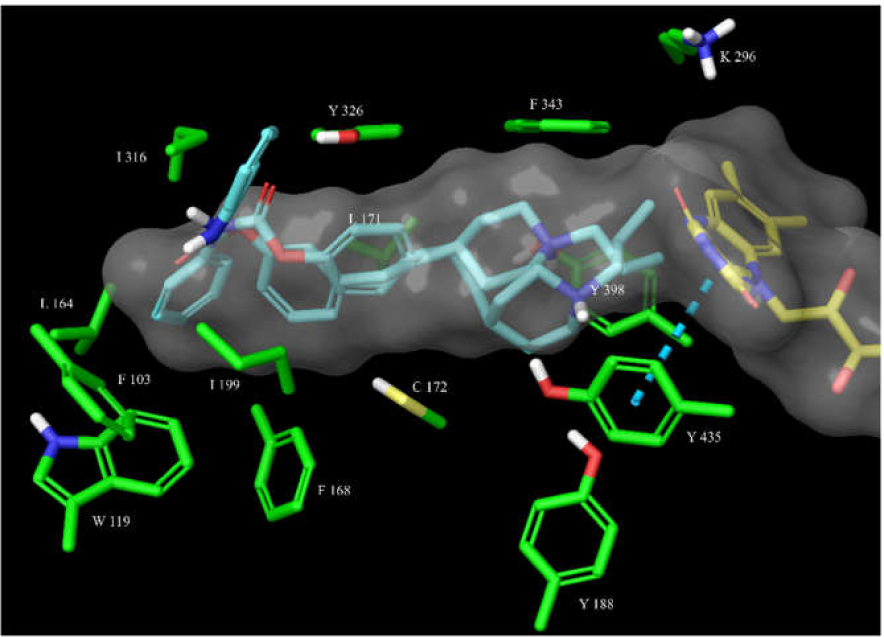
Figure 6. The overlay of docked covalently bound 12 and 13 (shown as cyan sticks) in the hMAO-B active site. The active site is shown as surface with the relevant amino acid residues shown as green sticks and the FAD cofactor as yellow sticks. The π - π interactions are represented by a blue dashed line. Both inhibitors display steric discomplementarity with the extended, flat active site